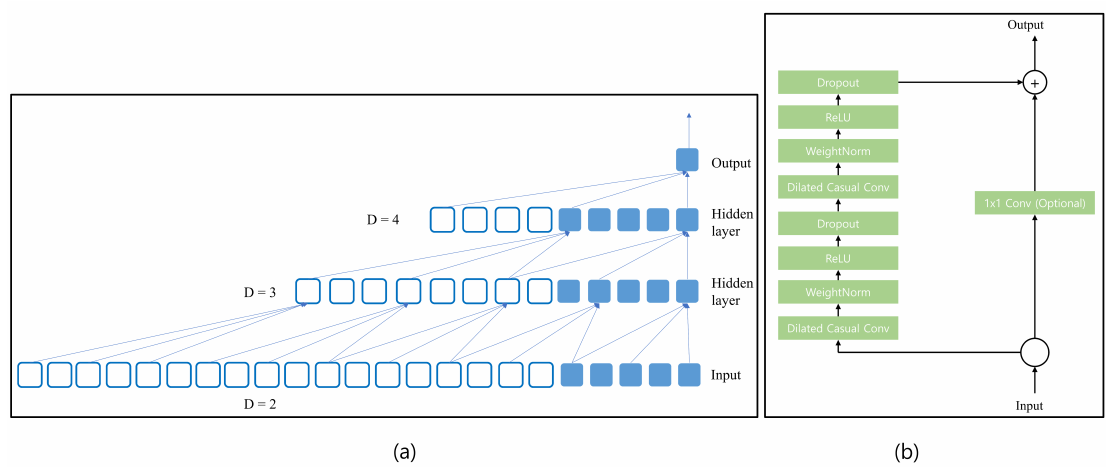
Figure 3. ( a ) Example of TCN with different dilation factors 2, 3, and 4 with kernel size 3, ( b ) different layers are present in the TCN